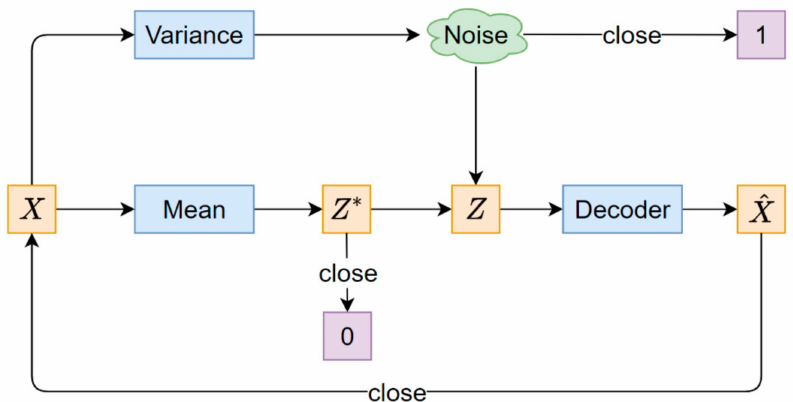
Figure 2. The entire training process of variational auto-encoder. X is trained by two encoders to obtain the mean and variance, where the encoder that obtains the mean converges to 0 through Gaussian noise to make the decoder robust to noise; the other encoder that obtains the variance, which makes the variance obtained from training converge to 1 to dynamically adjust the intensity of noise, thus further optimizing the decoder; the ˆ X obtained through the decoder is continuously optimized to approach X through the loss